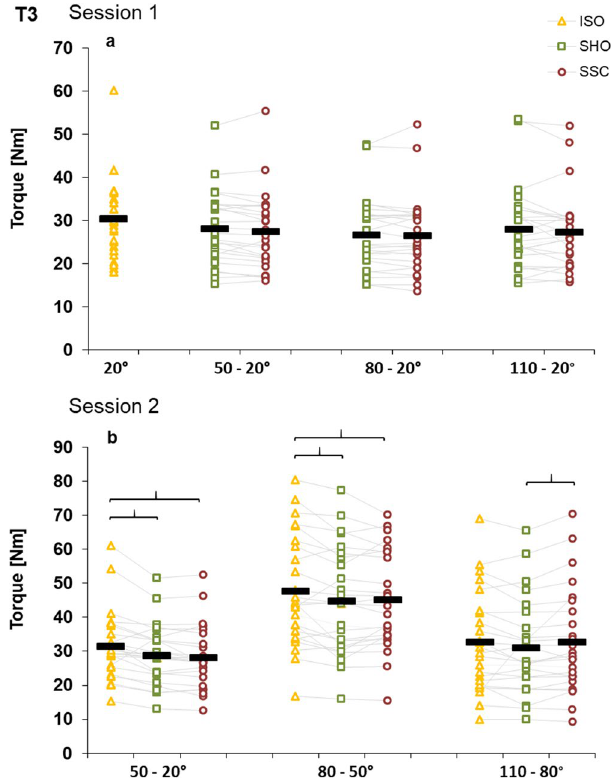
Figure 5. Mean (n = 25, thick horizontal line) (and mean of each individual subject) values of torque in the steady-state after knee rotation (T3) in session 1 with varying SHO- and SSC-magnitudes ( a ) and in session 2 with varying muscle–tendon unit lengths ( b ). Yellow triangles represent the isometric fixed-end reference conditions at corresponding dynamometer angle (ISO), green squares represent shortening-hold conditions (SHO), whereas red circles represent stretch–shortening conditions (SSC). In the SSC condition the shortening phase was preceded by the corresponding stretch